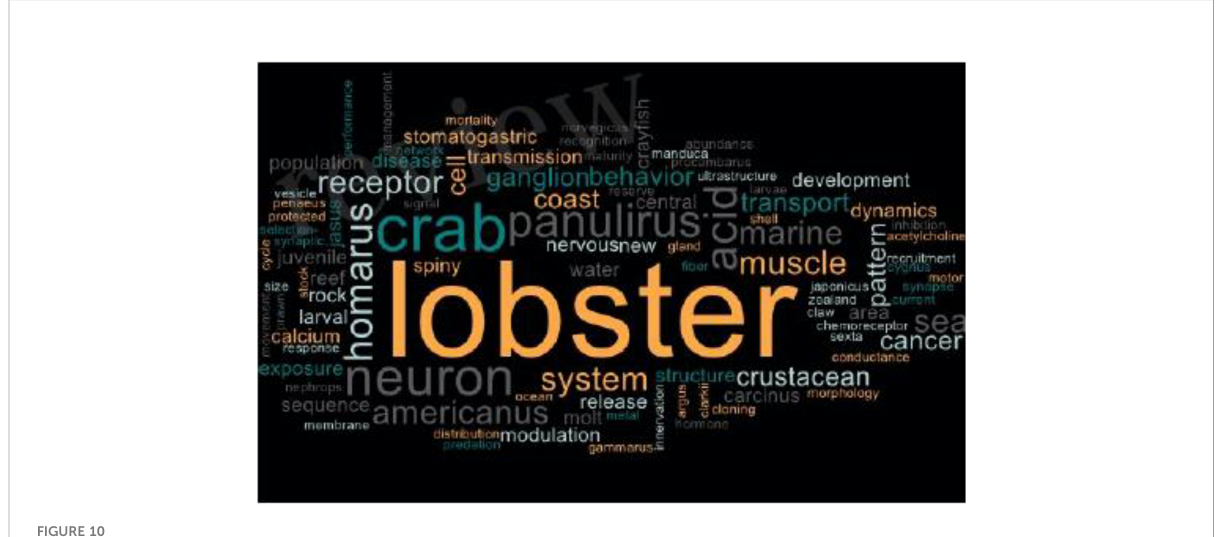
FIGURE 10 Most cited keywords in marine lobster research between 1970 and